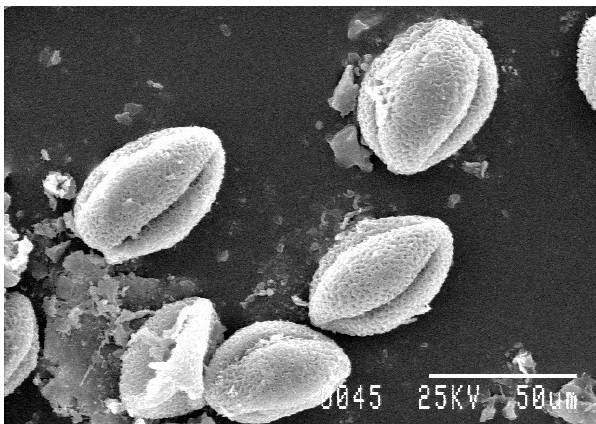
Fig. 2. X600, showing tricolpate pollens of Nelumbo nucifera Gaertner